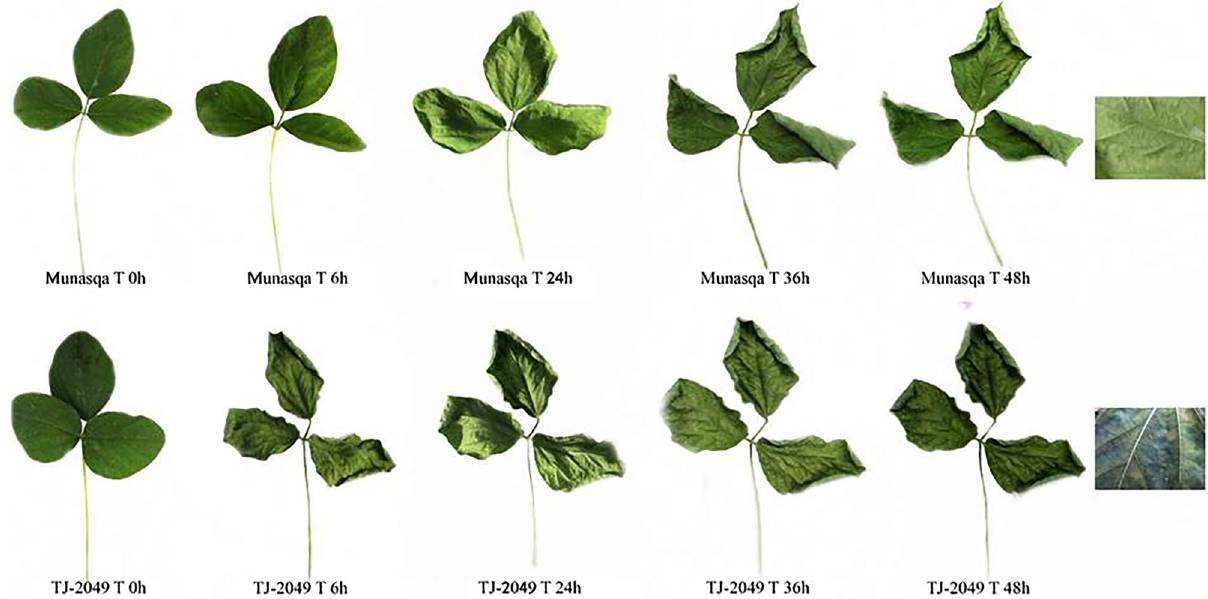
Figure 3. MUNASQA and TJ2049 response to wilting air desiccation. Whole leaves (n = 6), collected from R5 plants, were exposed to air desiccation at 32 °C and photographed after 0, 6, 24, 36, and 48 h to evaluate the appearance of wilting